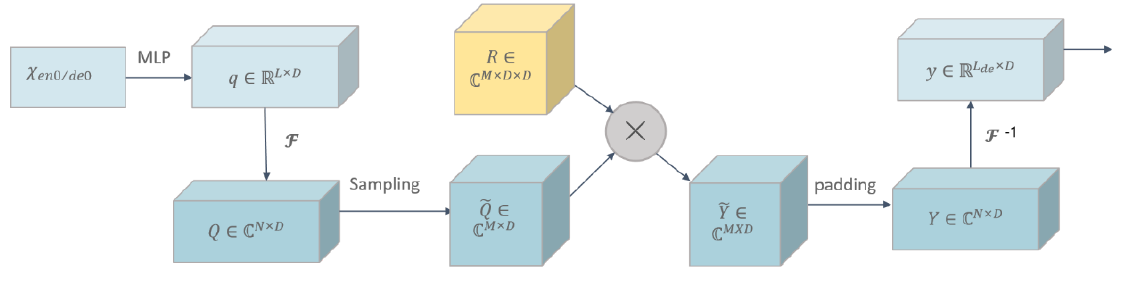
Figure 2. Frequency Enhanced Block.